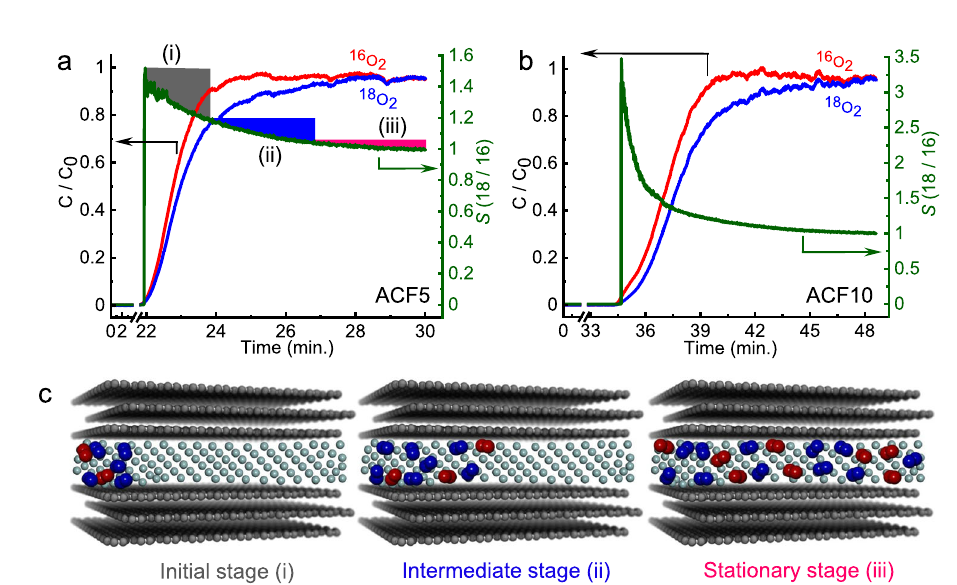
Fig. 4 Selectivity for 18 O 2 via breakthrough experiments. a Breakthrough curves and selectivity on ACF5 at 103 K. b Breakthrough curves and selectivity on ACF10 at 103 K. The curves demonstrated the distinct separation of 18 O 2 from 16 O 2 . Here, C is the concentration of the component in the adsorption column outlet, and C 0 is the total concentration of all feed gases { 18 O 2 (0.5) + 16 O 2 (0.5)}. c Slit pore models demonstrate the selective adsorption process under He (grey spheres) fl ow corresponding to the high selectivity in the initial stage (i), intermediate (ii), and stationary (iii) stages of adsorption separation. The red and blue spheres represents adsorbed 16 O 2 and 18 O 2 molecules,